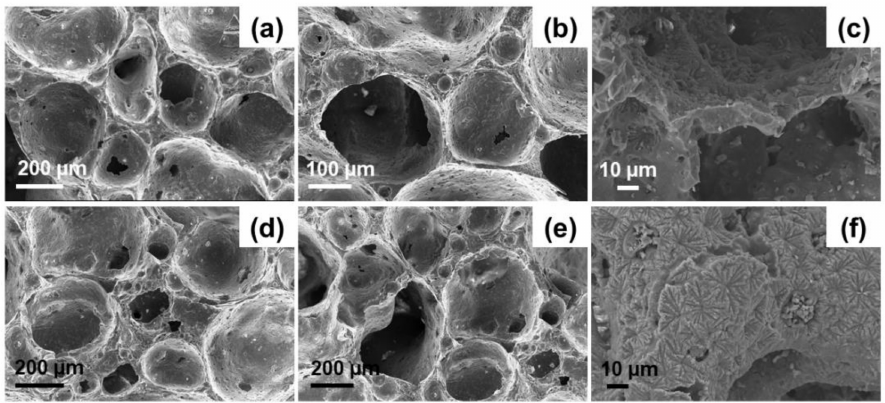
Figure 2. FE-SEMimagesofdolomite-foamedscaffoldsD-800( a – c )andD-850( d – f